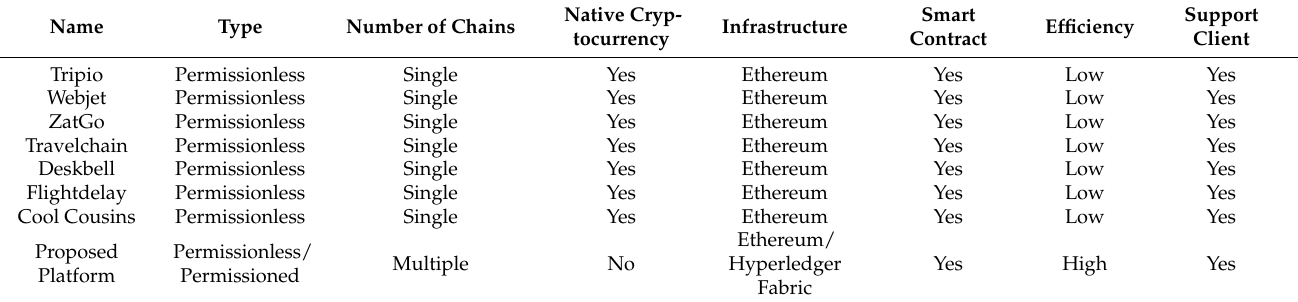
Table 3. Comparative study of the proposed system with existing